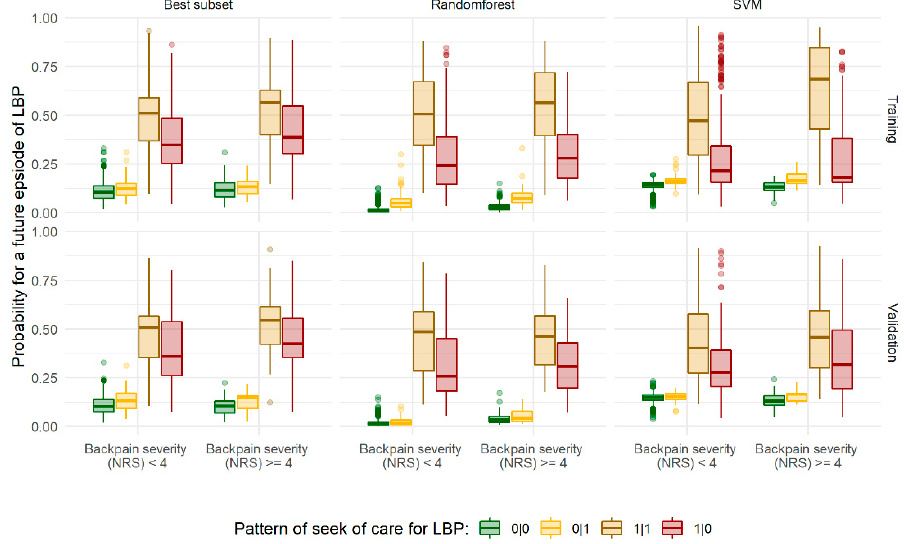
Figure 3. Predicted probabilities of future consultations for low back pain (LBP) stratified by the applied method (best subset vs. randomforest and support vector machines (SVM) ), backpain severity (NRS), data source, and consultation patterns of seeking care. (Seek of care: 0|0 = no ICD-10 codes suggestive for LBP in any of the analysis periods (N = 2229), 0|1 = ICD-10 codes suggestive for LBP only during follow-up (N = 267), 1|1 = ICD-10 codes suggestive for LBP in all analysis periods (N = 601), 1|0 = history of back pain prior baseline and/or ICD-10 codes suggestive for LBP at baseline but not in the follow-up (N = 740)).